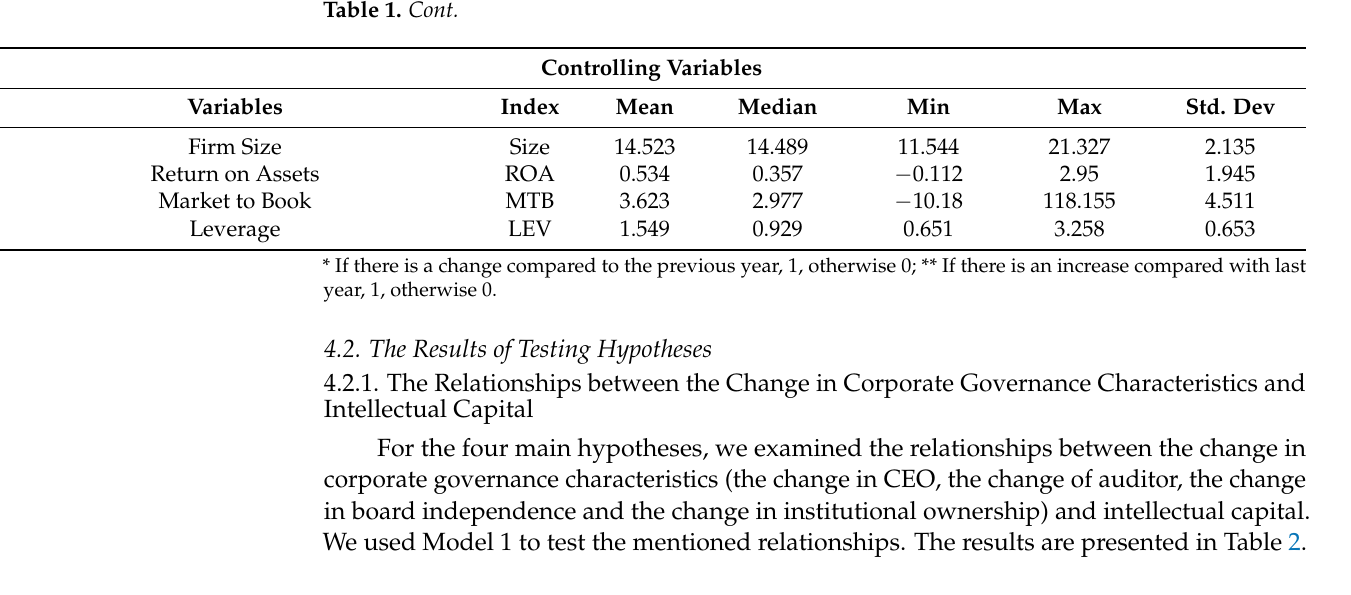
Table 2. The results of the four main